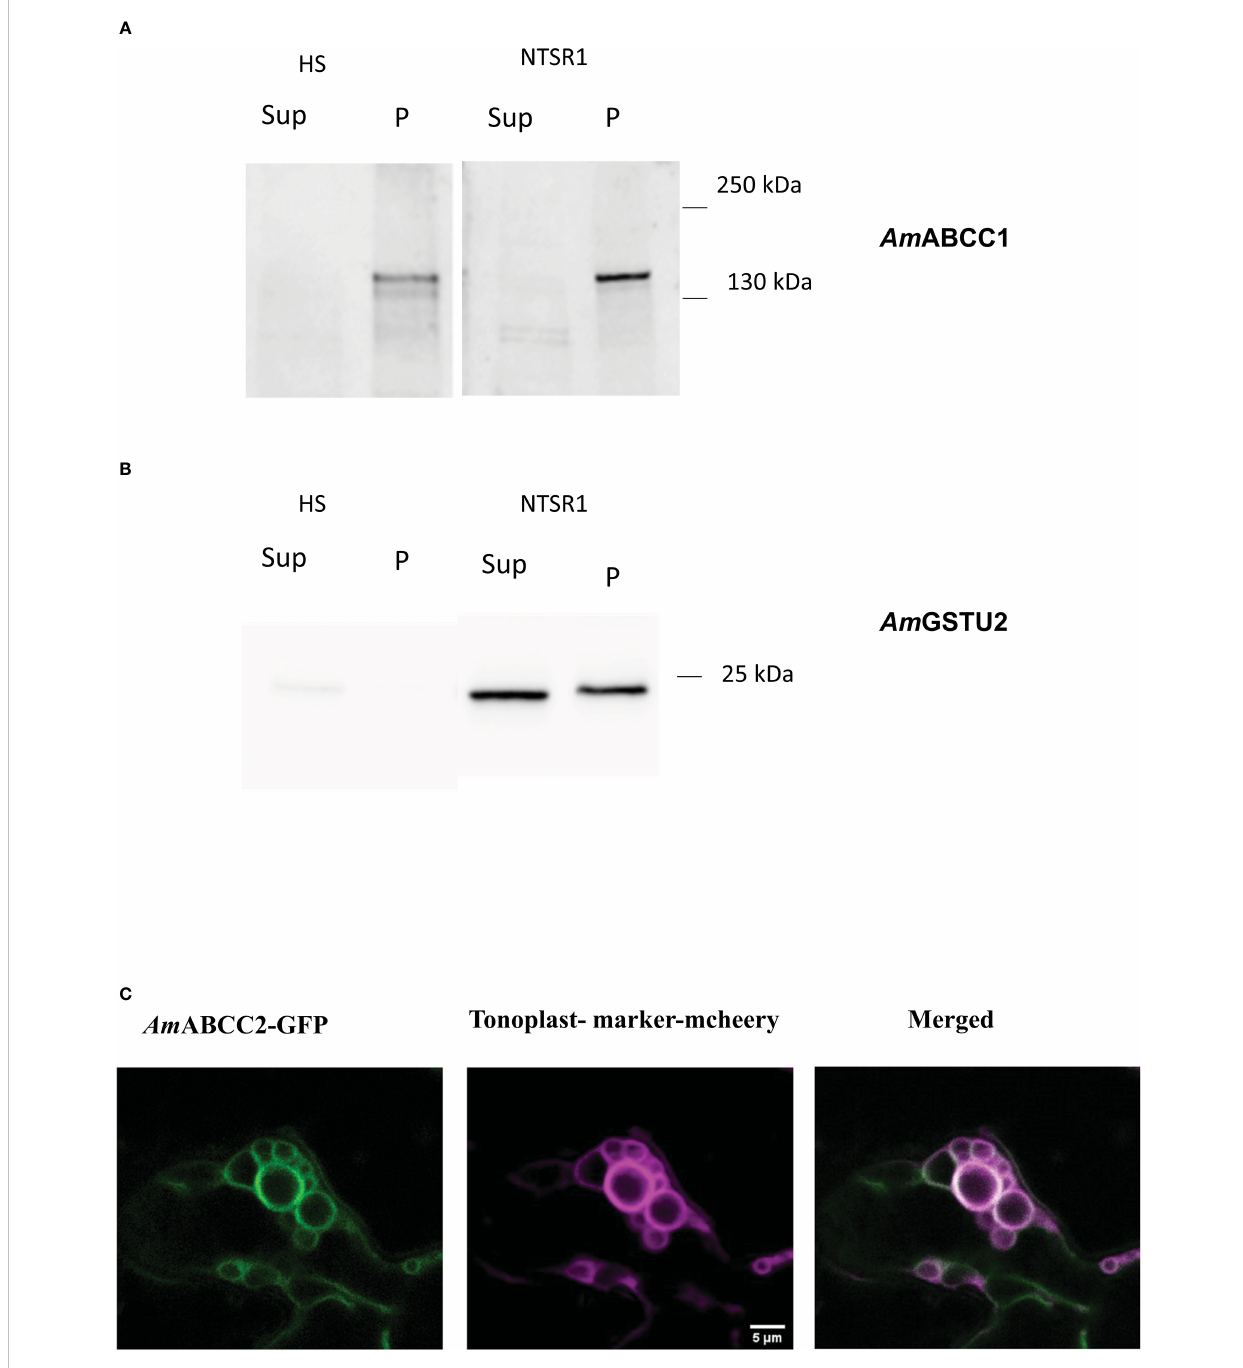
FIGURE 5 Expression of Am ABCC proteins in planta . Protein immunoblots of (A) Am ABCC1 and (B) Am GSTU2a in the soluble (Sup) and membrane fraction (P) from HS and NTSR1 blackgrass plants. (C) Confocal images showing intracellular localization of C-terminally GFP-tagged Am ABCC2 transiently expressed in N. benthamiana leaf epidermal cells (green). The signal of the tonoplast marker g -TIP-RFP is shown in magenta, with the merged image showing the co-localization of Am ABCC2-GFP and the tonoplast marker in tobacco